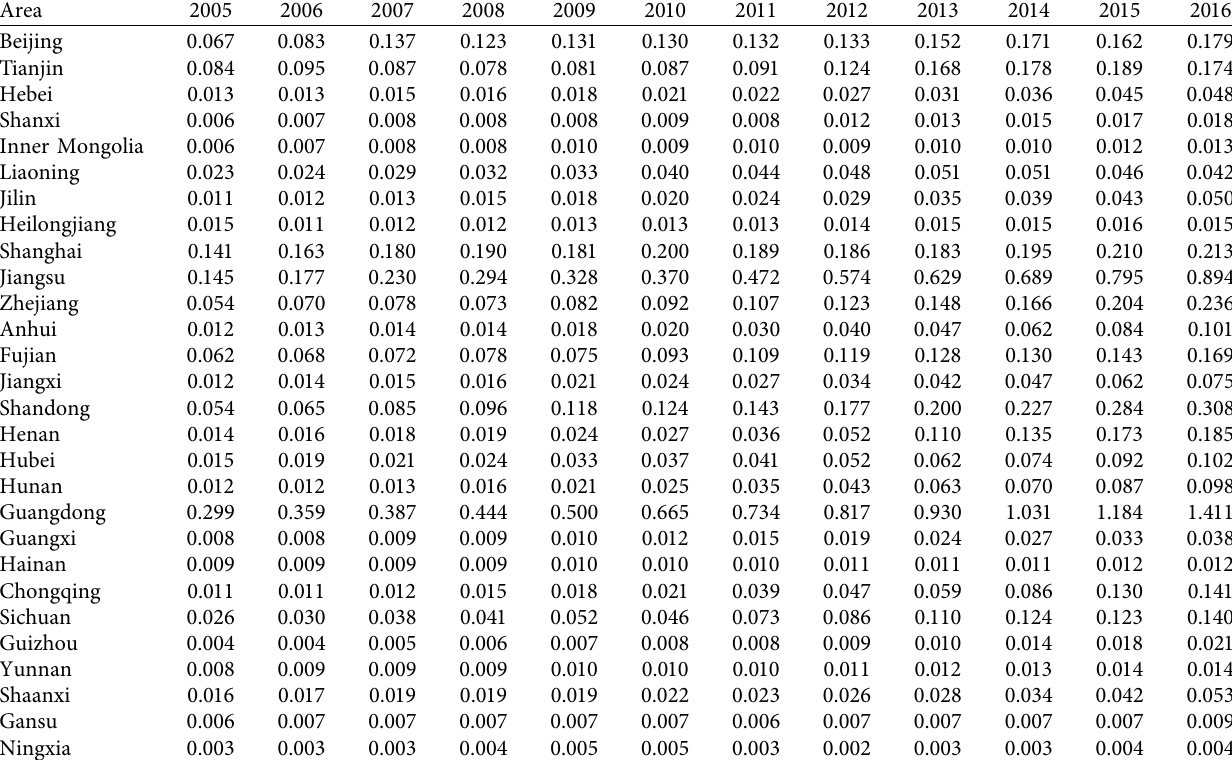
Table 2: Comprehensive output value of China’s interprovincial high-tech manufacturing industry considering environmental